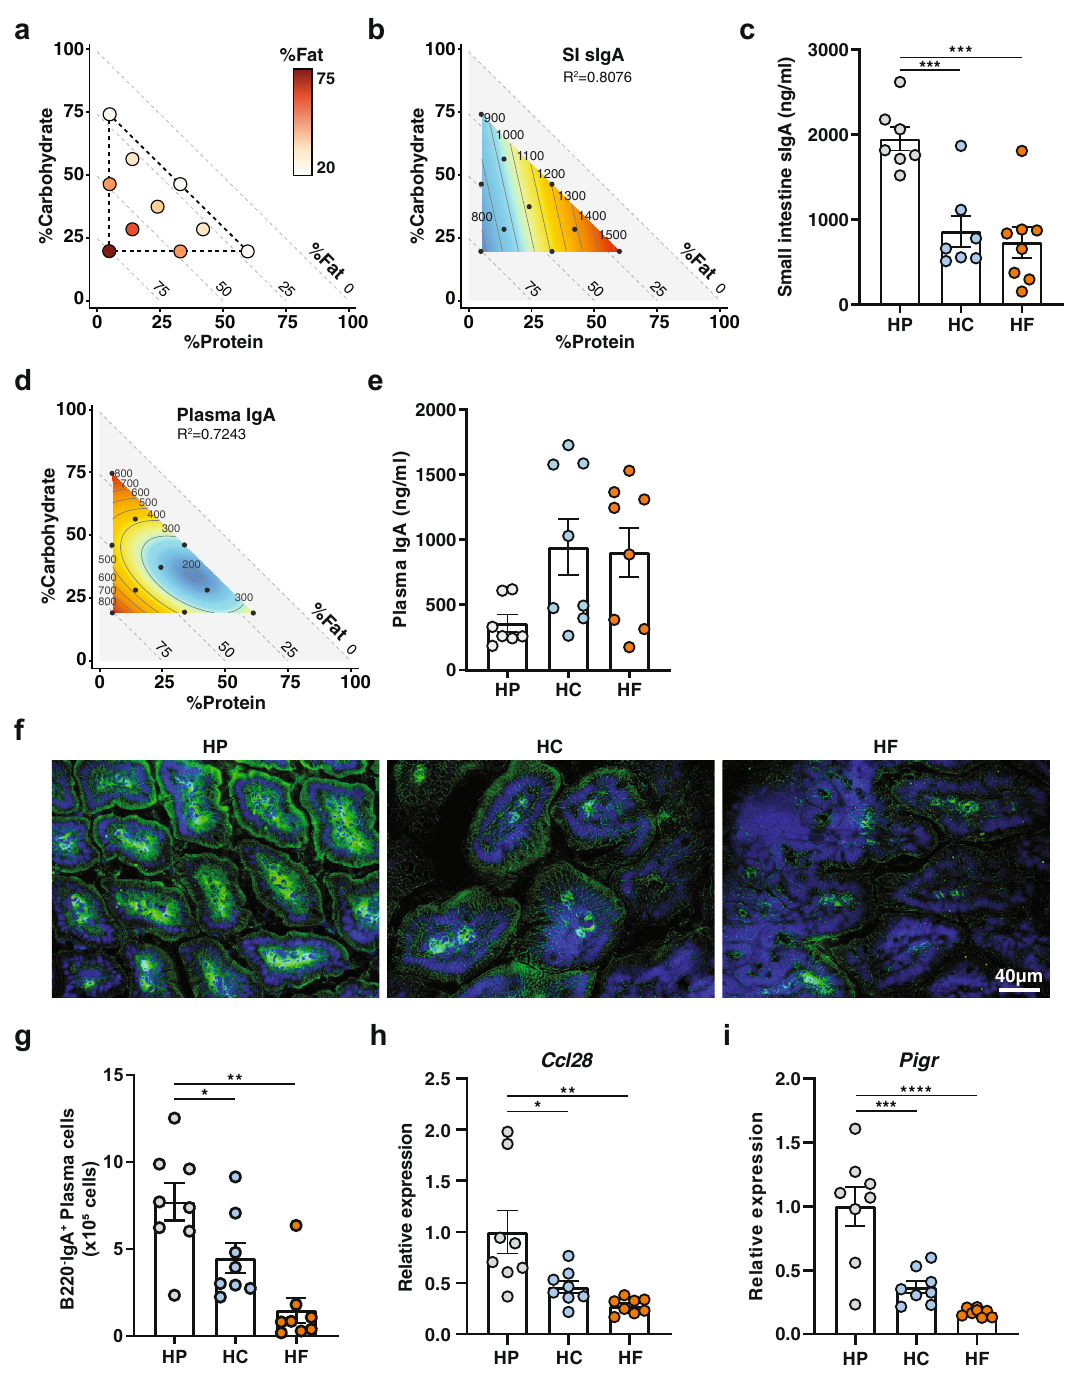
(Fig. 1h). Additionally, the expression of the gene encoding for pIgR, involved in the transport of sIgA to the lumen via the epithelium, was signi fi cantly increased under HP feeding conditions (Fig. 1i).